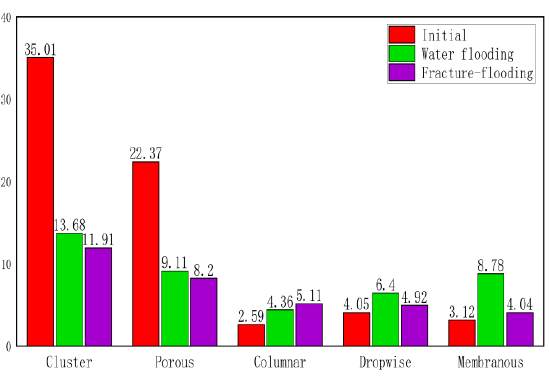
Figure 16. Comparison of remaining oil content of different types based on CT scans .